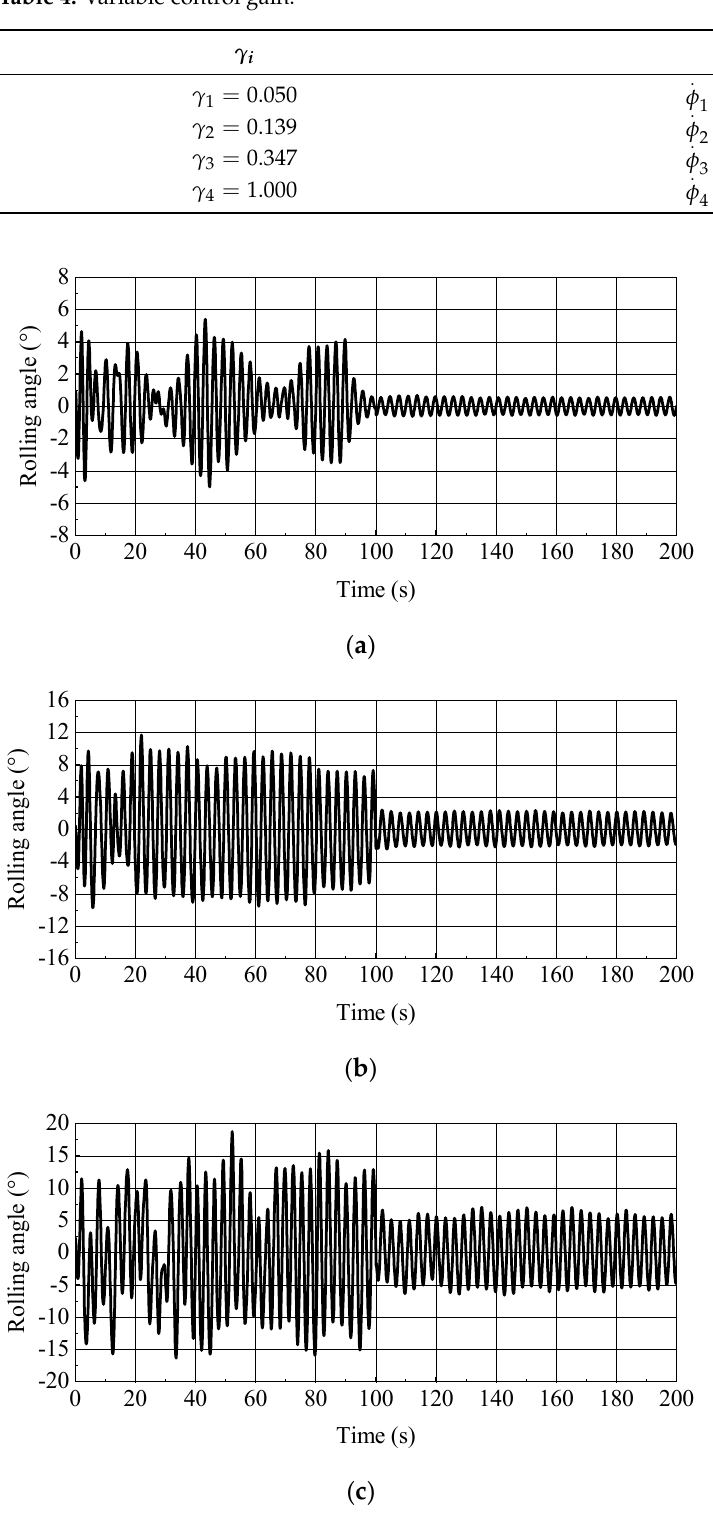
Figure 3. Time-series roll motion of ship. ( a ) H = 0.5 m; ( b ) H = 1.5 m; ( c ) H = 2.5 m.